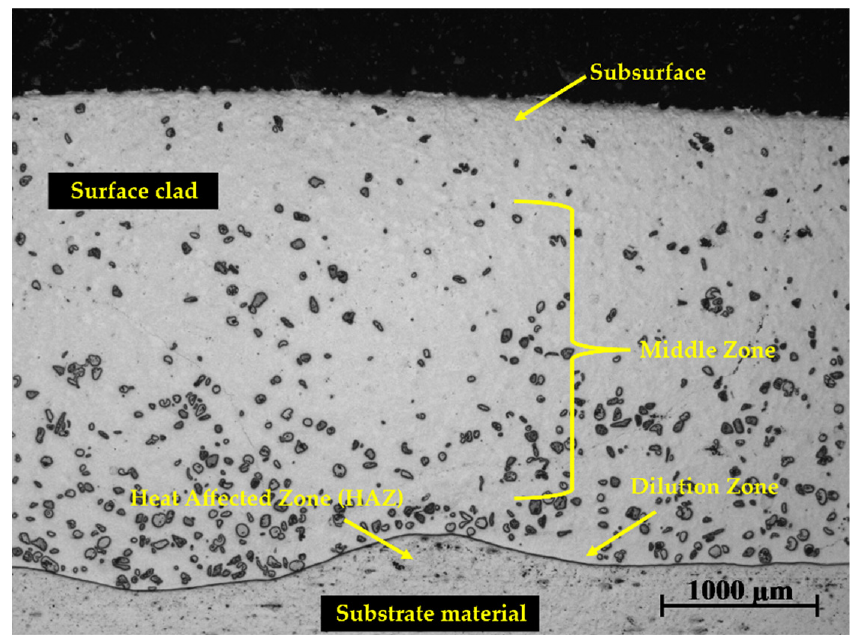
Figure 8. Cross-section of deposited surface layer of sample 1-PE showing the subsurface of the layer,